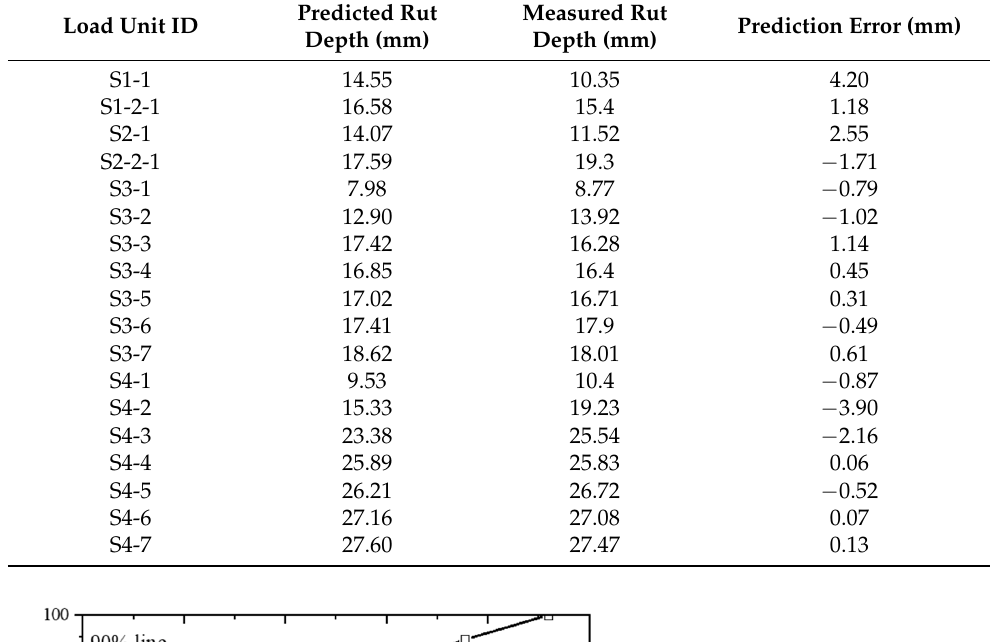
Table 7. The predicted and measured cumulative rut depth results of the different load units of test sections S1–S4.